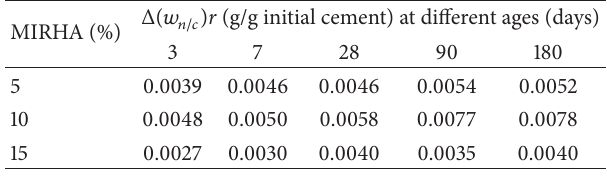
Table 7: Δ𝑤 𝑛/𝑐 due to the presence of MIRHA by OD/FI.